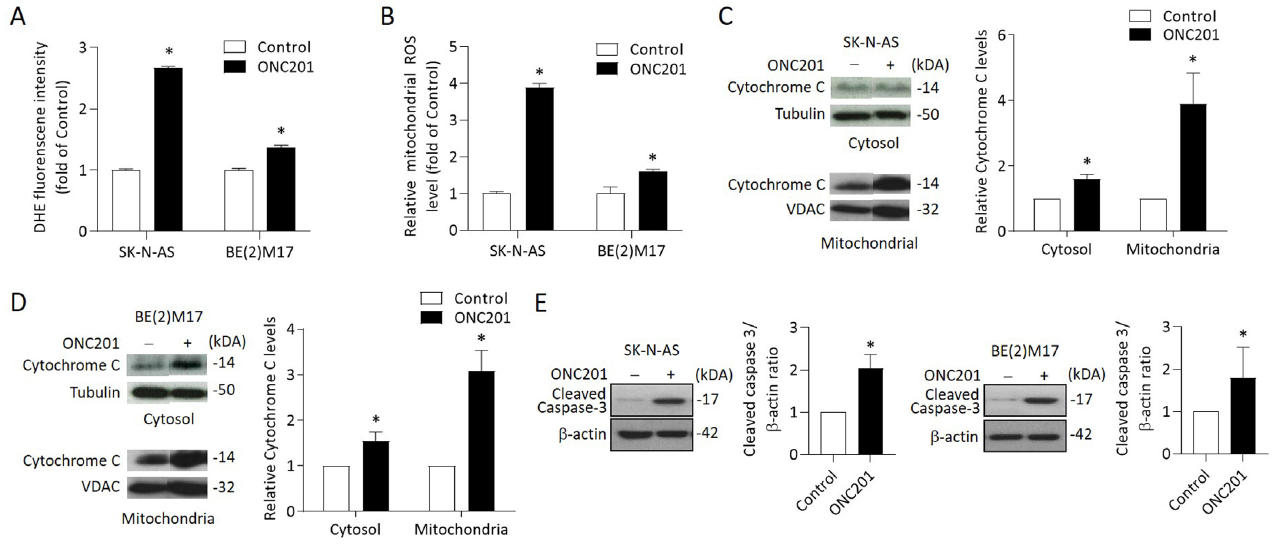
Figure 4. Effects of ONC201 on mitochondria-mediated apoptosis signaling in NB cells: ( A ) The intracellular ROS production of ONC201-treated cells was detected by DHE staining. The relative intensity of DHE fluorescence was analyzed by flow cytometry. ( B ) Mitochondrial ROS was detected by MitoSOX Red and immediately analyzed by flow cytometry. Data are expressed as fold change compared with control group. ( C , D ) To detect cytochrome C release, cytosolic and mitochondrial fractions of NB cells were subjected into 15% SDS-PAGE and probed with anti-cytochrome c antibody by Western blot analysis. Alpha-tubulin and VDAC1 were used as the cytosolic and mitochondrial internal control, respectively. ( E ) The protein levels of cleaved caspase 3 were detected by Western blot. The relative protein ratio was normalized with β -actin using Image Pro-plus analysis software. All data were obtained from three independent experiments, and are expressed as mean ± SD. * p < 0.05.